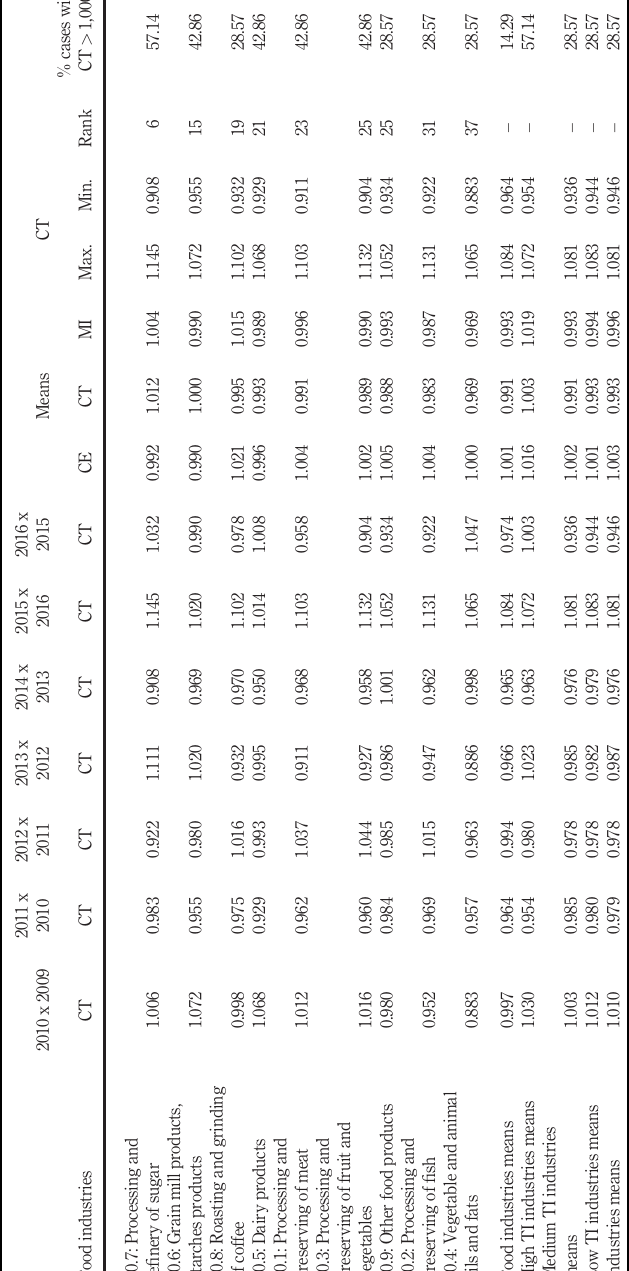
Table 5. Changes in technology (CT) evolution in food